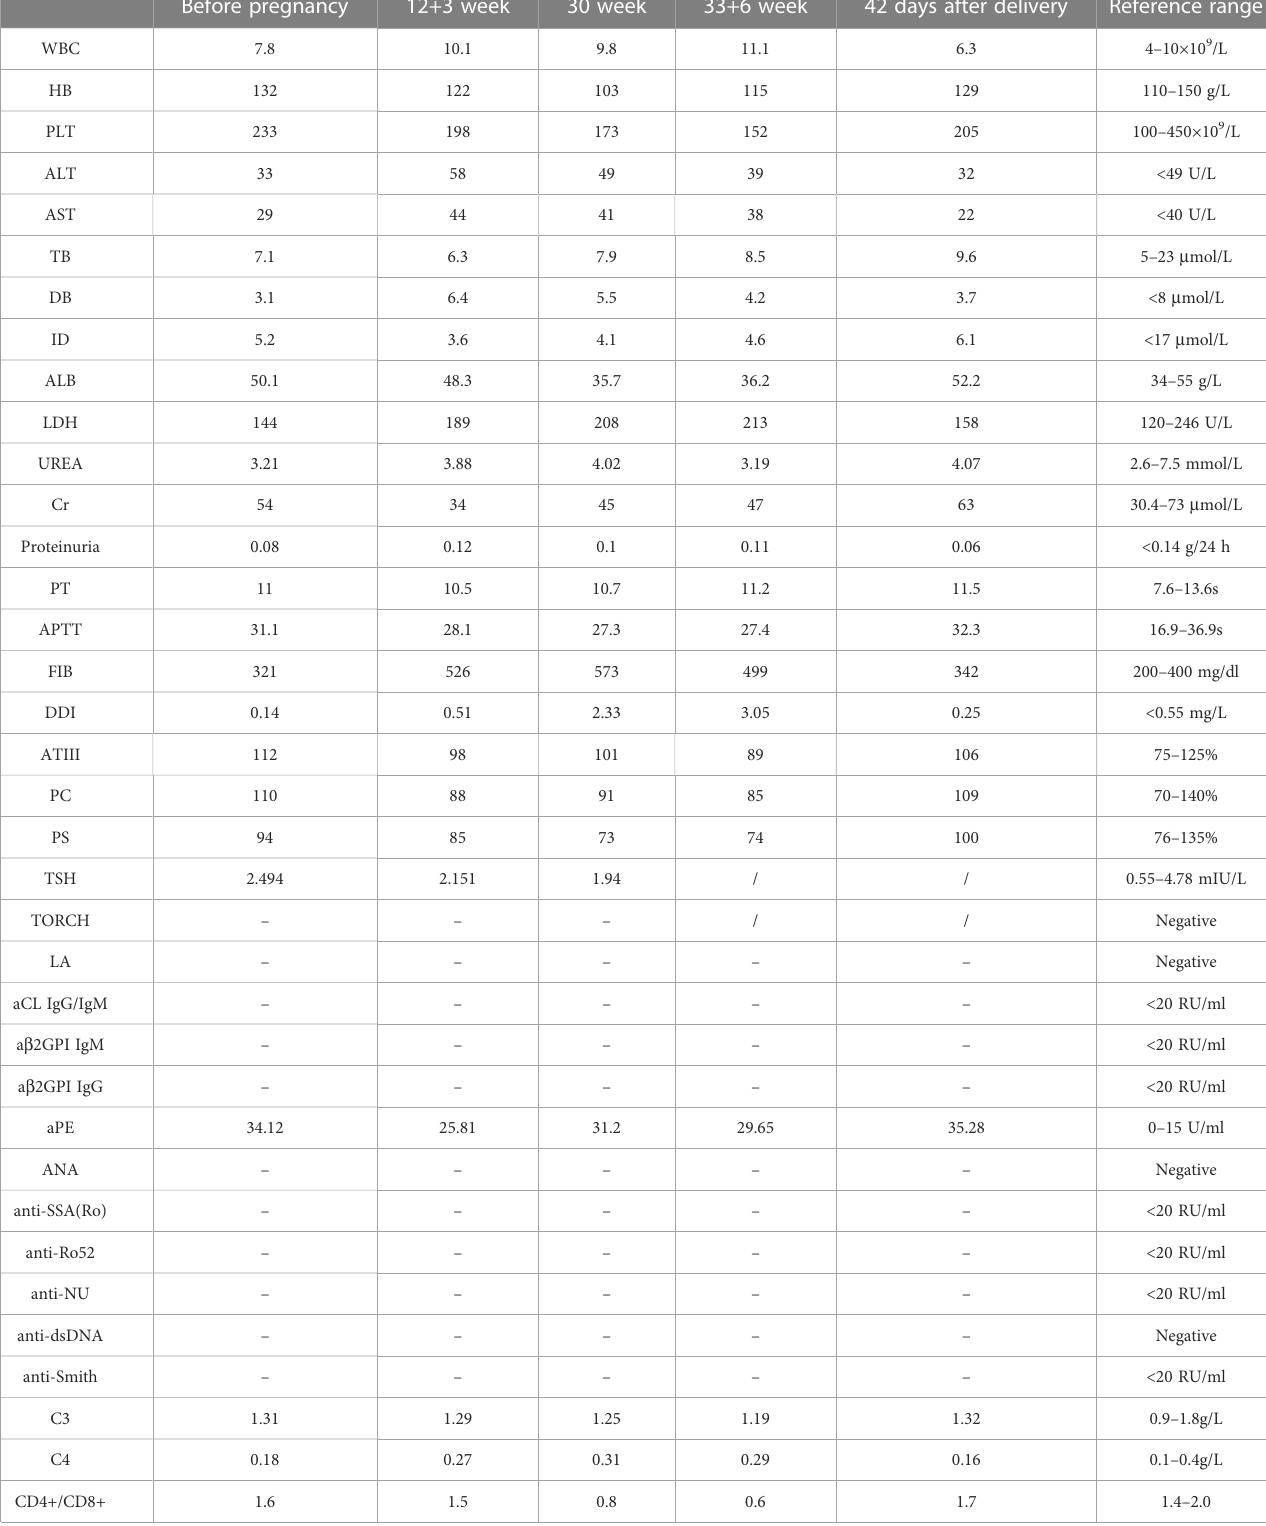
TABLE 4 Case 2 laboratory fi ndings during this